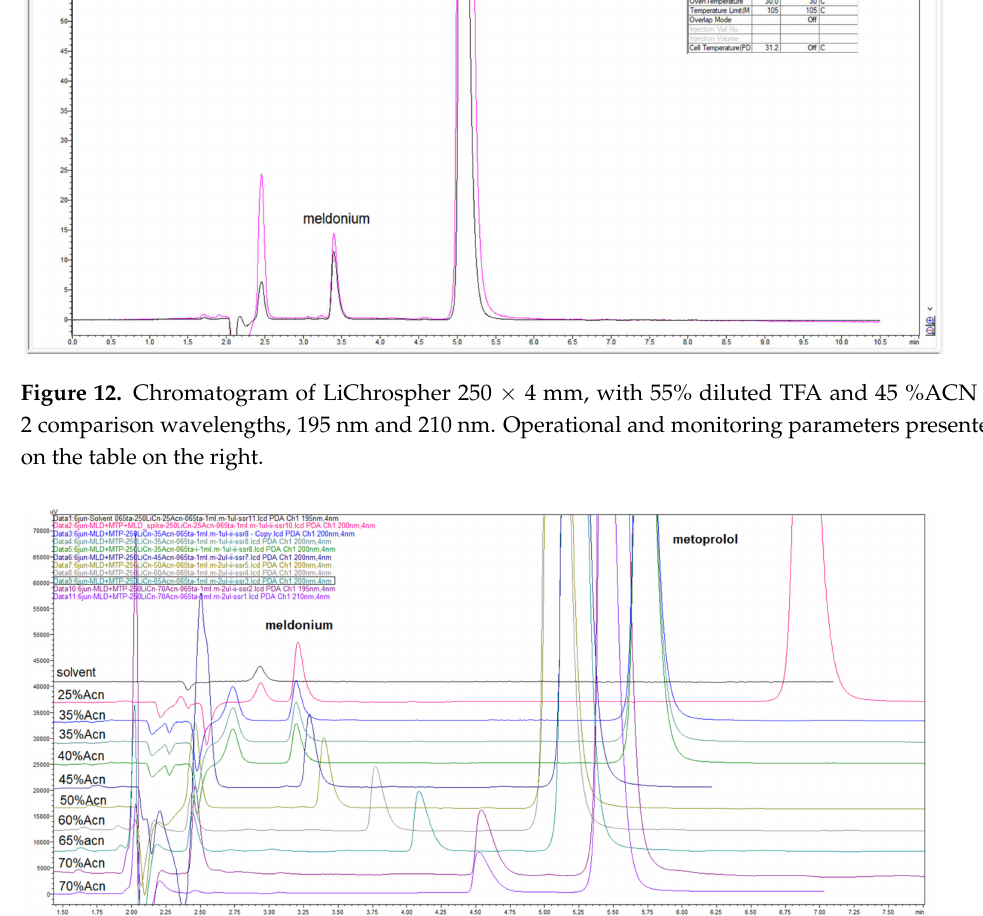
Figure 13. Overlaid chromatograms of LiChrospher CN 250 × 4 mm column experiments, that were useful for rough and fine tuning of analyte peaks according to presence of other compounds. Peaks mapping as a function of acetonitrile percentage in eluents, in the range of 25–70%